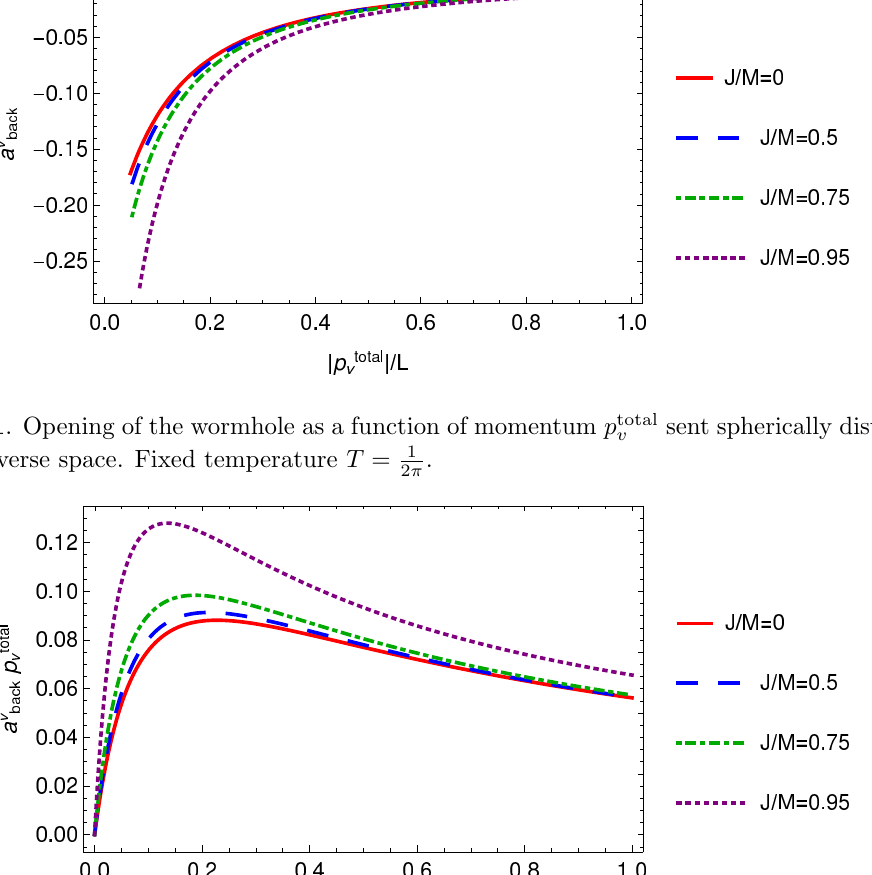
p total for spherically distributed momen- v back